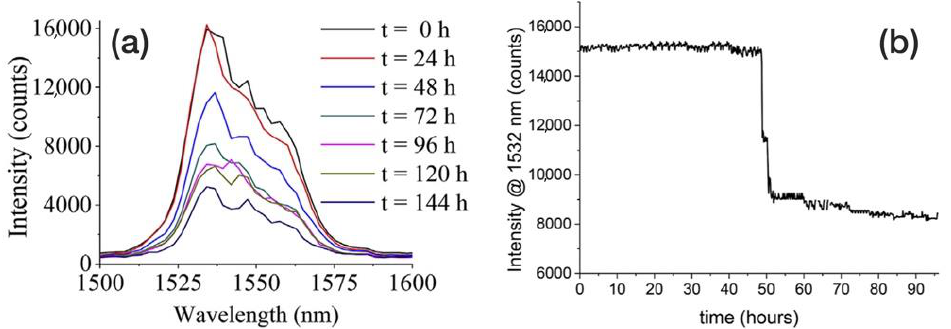
Figure 16. ( a ) The evolution of light reflected by an embedded OFS with time. ( b ) An OFS signal drop due to water diffusion through the surrounding coating [29].